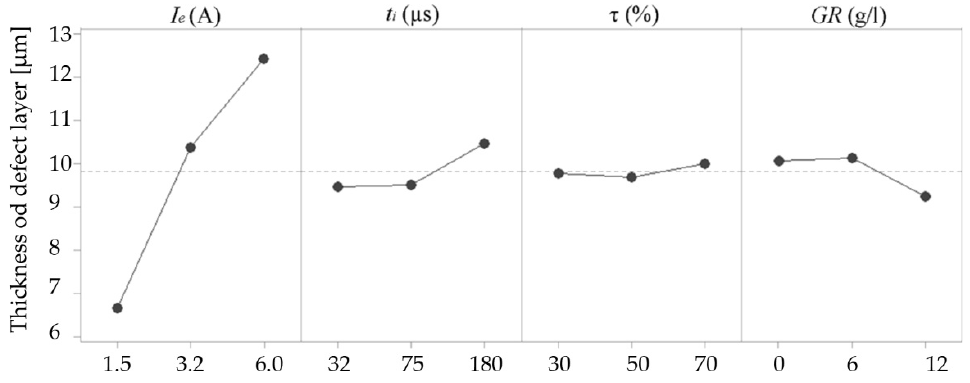
Figure 6. Response ANOVA graph for the thickness of the defect